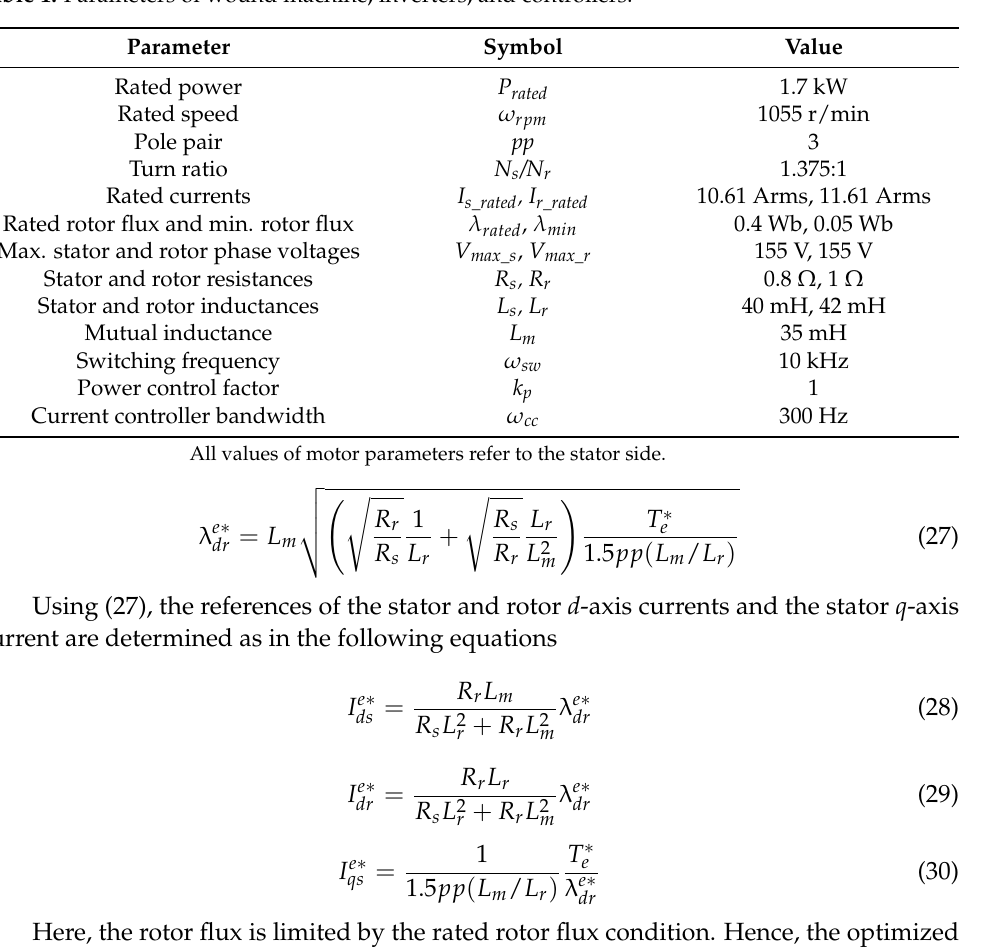
Table 1. Parameters of wound machine, inverters, and